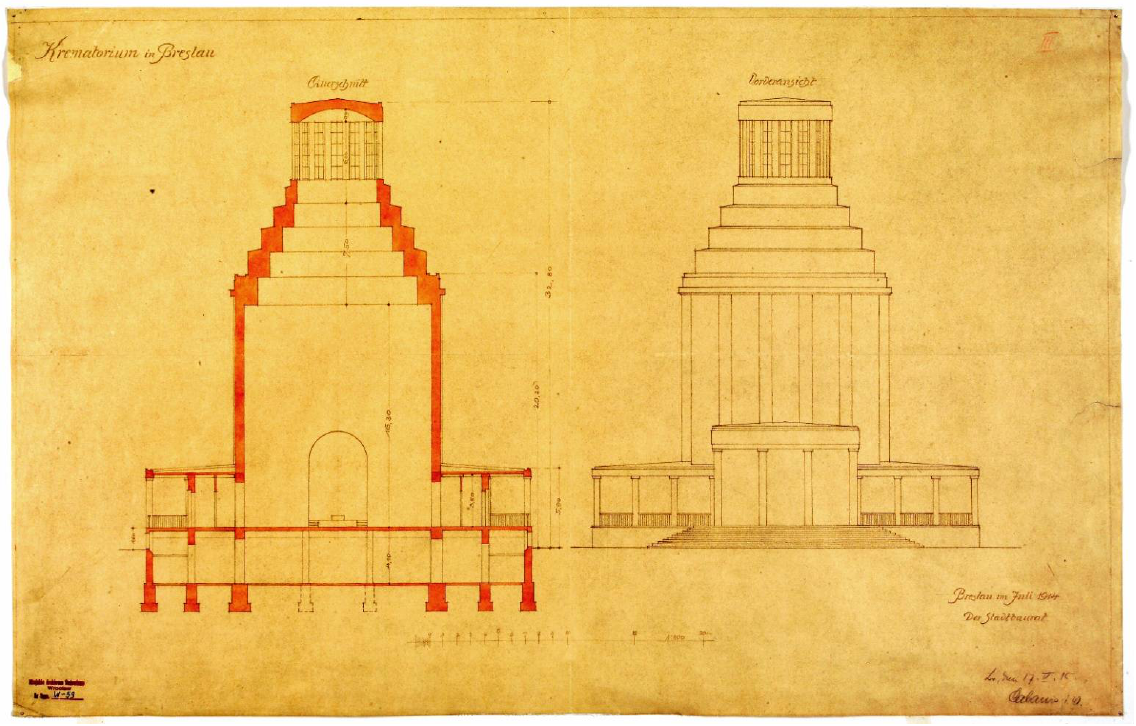
Figure 13. The crematorium design by Max Berg, cross section and front elevation, July 1914 (Wrocław Construction Archive, a branch of the Museum of Architecture in Wrocław).